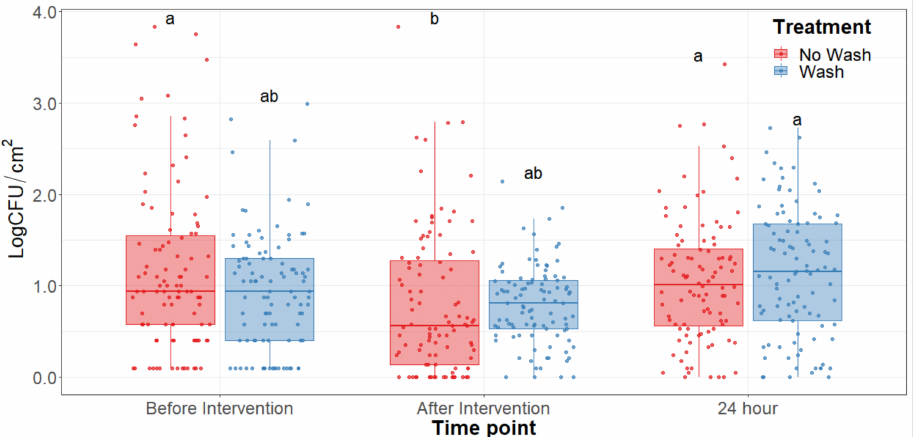
Figure 2. Psychrotroph counts of the beef carcass surface before and after the hot water wash interven- tion and 24 h chilling period. The horizontal line within the box plot represents the median. The box upper and lower limits represent the interquartile range, and the bars represent the 1.5xInterquartile Range. a,b Box plots with different letters are significantly different ( p <